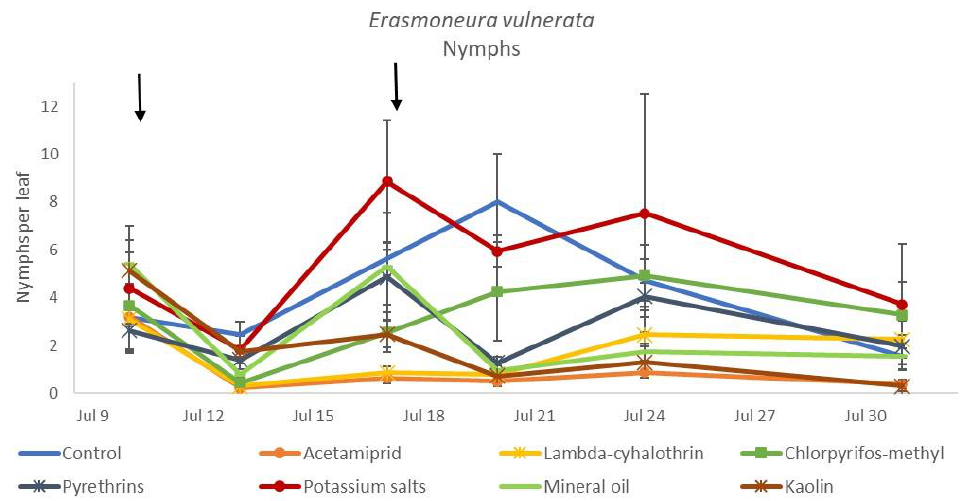
Figure 6. Dynamics of Erasmoneura vulnerata nymphs (mean ± std. err.) in the 2018 trial. Insecticides were applied one (first arrow) or two times (second arrow, see Materials and Methods section).